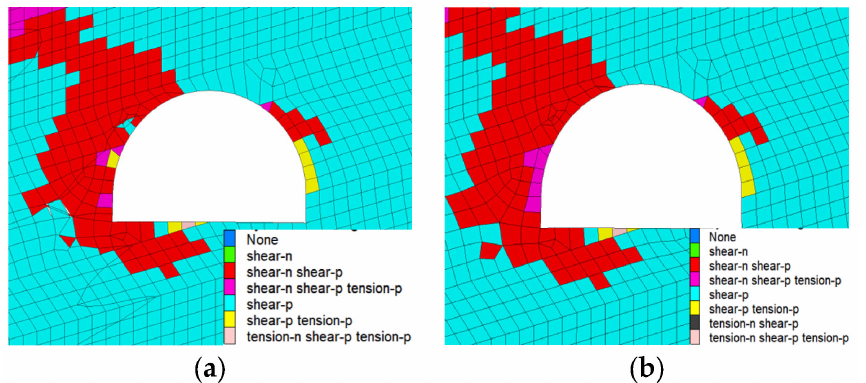
Figure 13. Development and distribution of a plastic zone of a roadway surrounding rock under different angles between maximum horizontal stress and the roadway. ( a ) Roadway plastic zone under vertical angle. ( b ) Roadway plastic zone under horizontal angle.